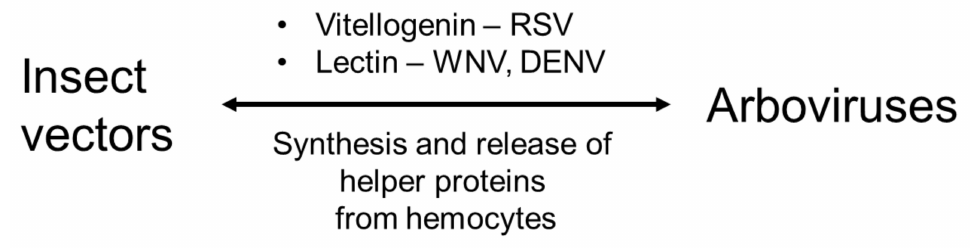
Figure 1. Unique hemocyte function in insect vectors for transmission of arboviruses. Hemocytes produce helper proteins to deliver the arboviruses to the salivary gland in L. striatellus for rice stripe virus (RSV) and A. albopictus for West Nile virus (WNV) and Dengue virus